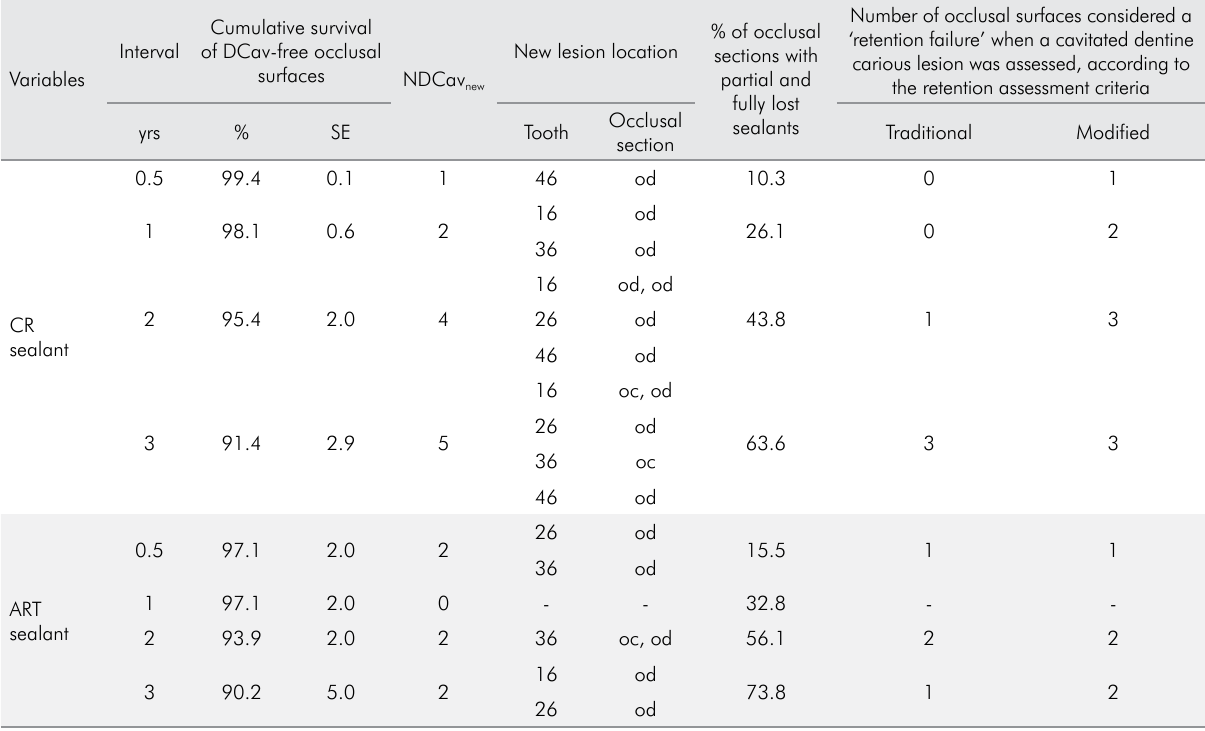
Table 5. Cumulative survival of cavitated dentine carious lesion-free occlusal surfaces [%(SE)], frequency distribution of cavitated dentine carious lesion location, percentage of occlusal sections with partial or fully lost sealants and retention failures at lesion detection according to the traditional and modified retention